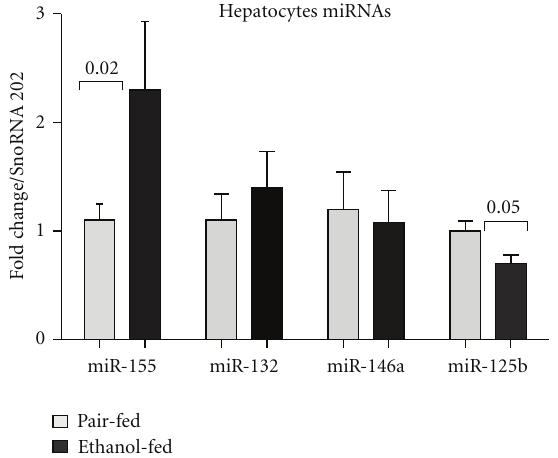
Figure 2: Induction of miR-155 in hepatocytes of alcohol-fed mice. Hepatocytes were isolated from the mice ( n = 5-6) after 4 weeks of feeding. Briefly, the livers were perfused, followed by digestion. Parenchymal cells (hepatocytes) were collected after low-speed centrifugation, washed, and were plated onto 6-well collagen-coated plates (BD-Biosciences). After 3h, floating cells were removed, and adherent cells were washed twice with PBS and lysed in QIAzole (Qiagen). Total RNA was isolated and miRNA expression was quantified by TaqMan miRNA assays (Applied Biosystems). The data were normalized to SnoRNA202 (endogenous control) and shown as the fold change over the pair-fed control group. Data represent mean values ± S.E.M. Statistical significance was determined using non-parametric Mann-Whitney test.